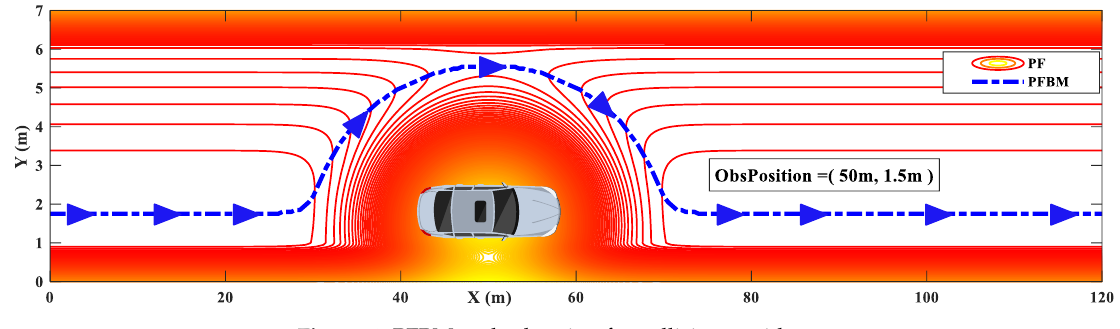
Figure 4. PFBM path planning for collision avoidance.